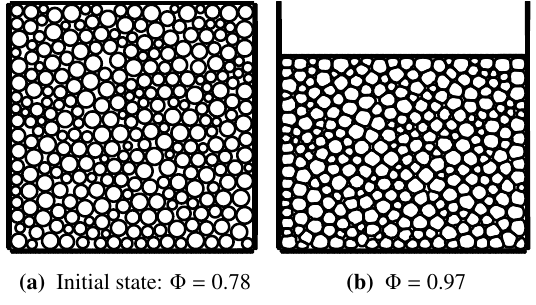
Figure 1. Snapshots of the initial configuration (a), and of the compaction of an elastic grain packing for packing fraction of  = 0 . 97